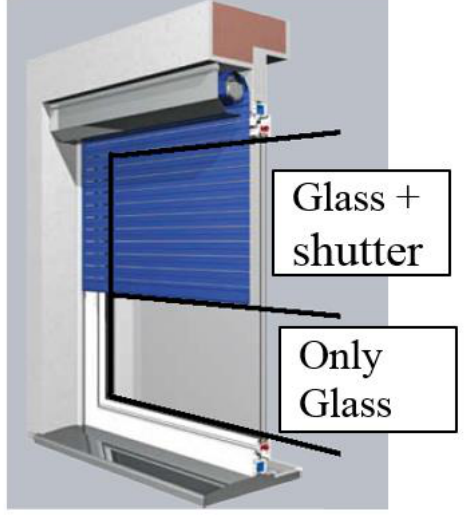
Figure 5. Considered sections of the windows [44].